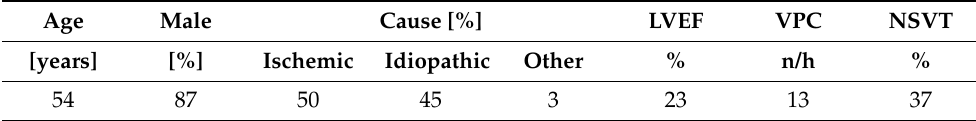
Table 1. Clinical characteristics of the population